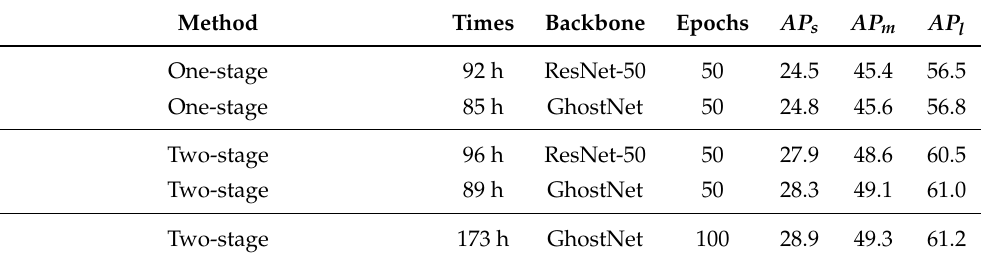
Table 1. Performance comparison of the proposed two-stage and conventional one-stage methods with Resnet-50 and GhostNet as a backbone.